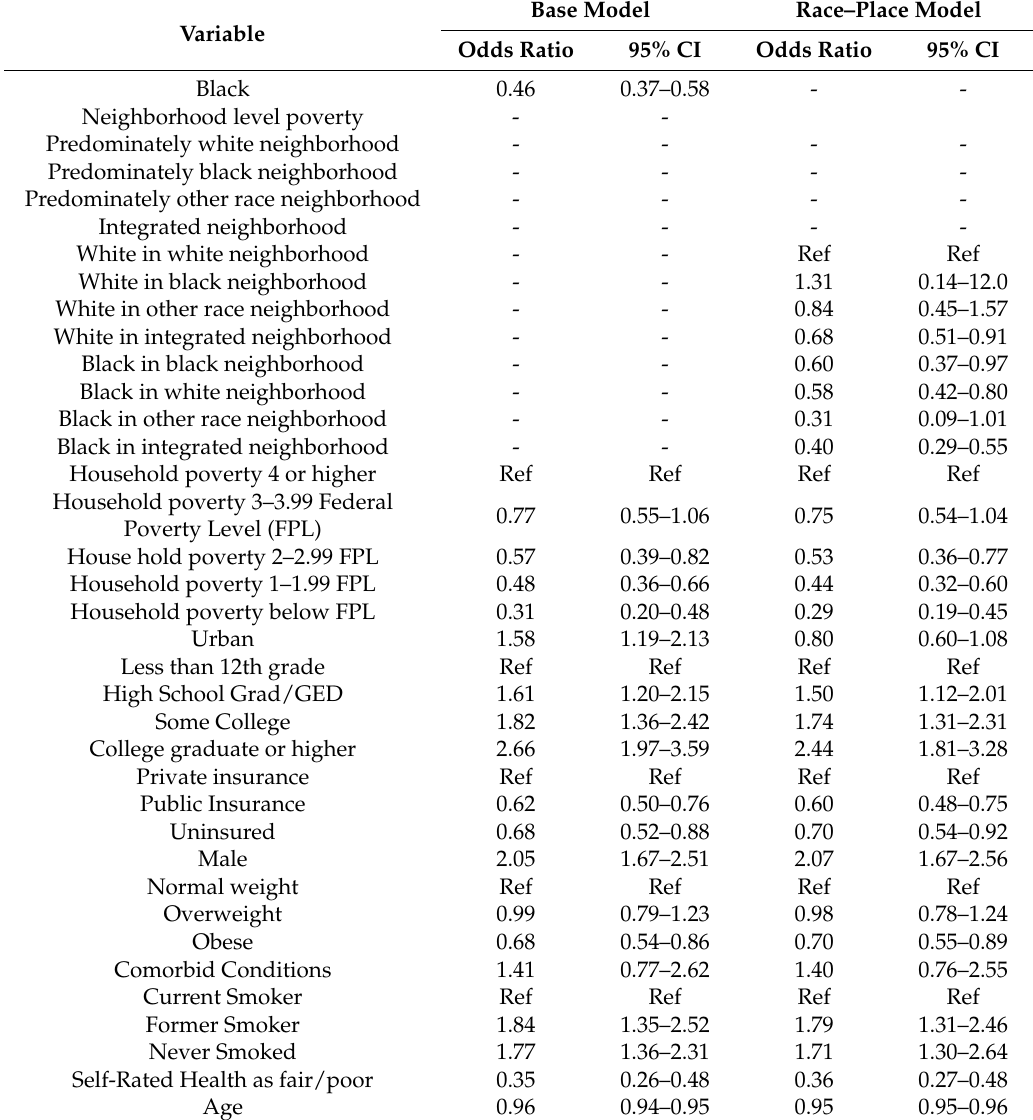
Table 2. Estimated odds of being physically active controlling for the race, neighborhood-level poverty, and racial composition of the neighborhood and the race–racial composition of the